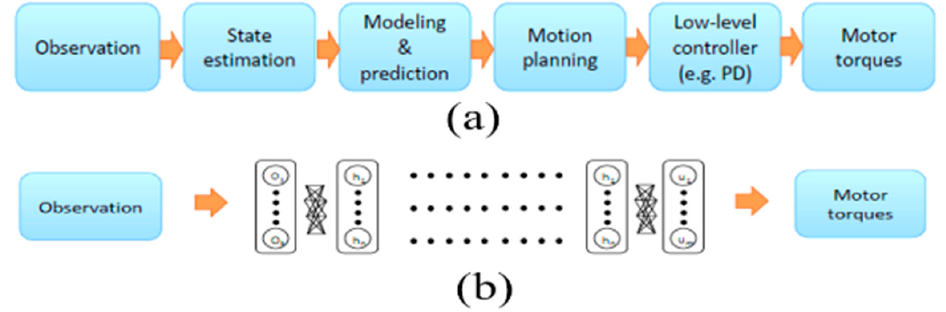
Figure 3. Standard robotics control vs DNN based end-to-end control [10]. ( a ) standard approach ( b ) deep neural network approach.